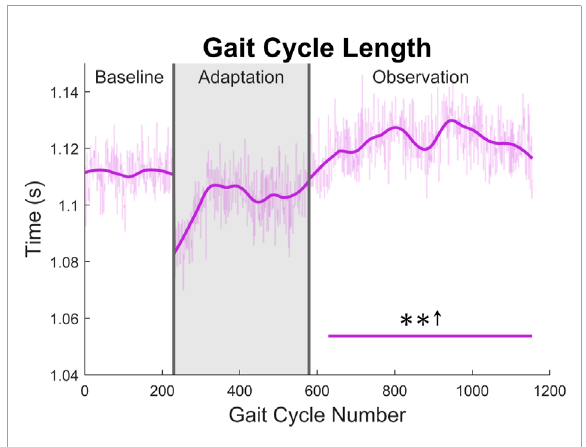
FIGURE 12 Gait cycle length with respect to time (measured from left heel strike to left heel strike). Significance is shown in the observation phase as compared to the baseline phase by the significance line. All significance testing was performed on “unsmoothed” data (seen in the lighter line). The darker line is the data smoothed by 2nd-degree polynomial local regression and was added only to allow the reader to more clearly see trends in the